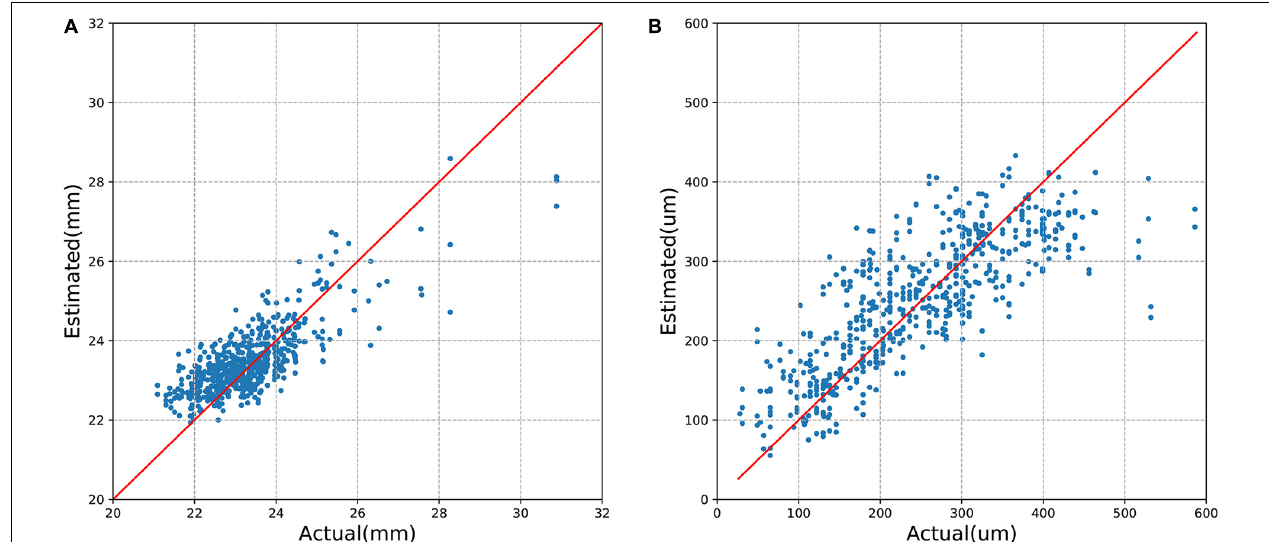
FIGURE 3 | Model performance of estimating ( A ) axial length and ( B ) subfoveal choroidal thickness.